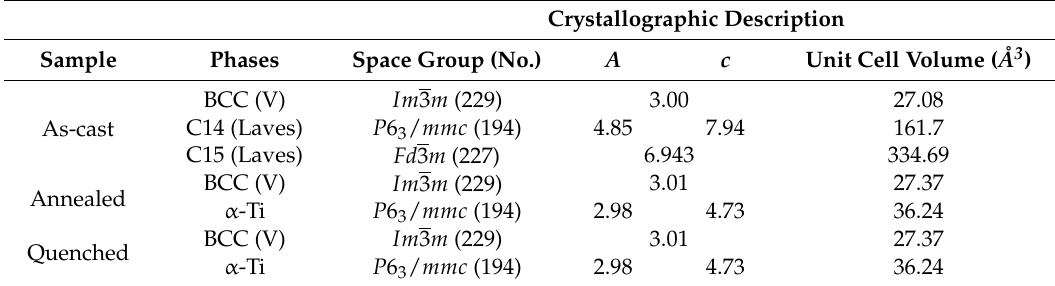
Table 1. XRD crystallographic parameters of the as-cast and heat-treated Ti 34 V 40 Cr 24 Fe 2 . Crystallographic Description